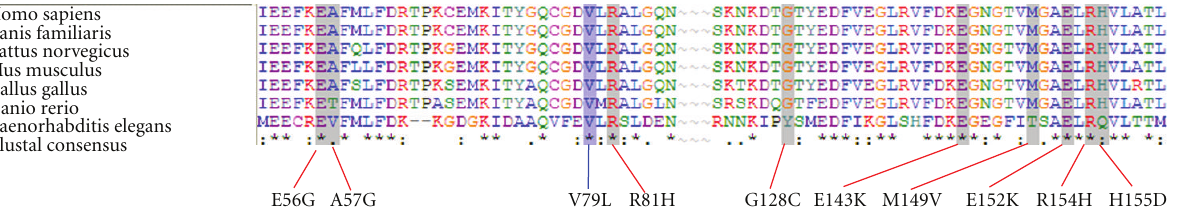
Figure 4: A homology analysis of the known MYL3 mutations, the valine in residue 79 is highly